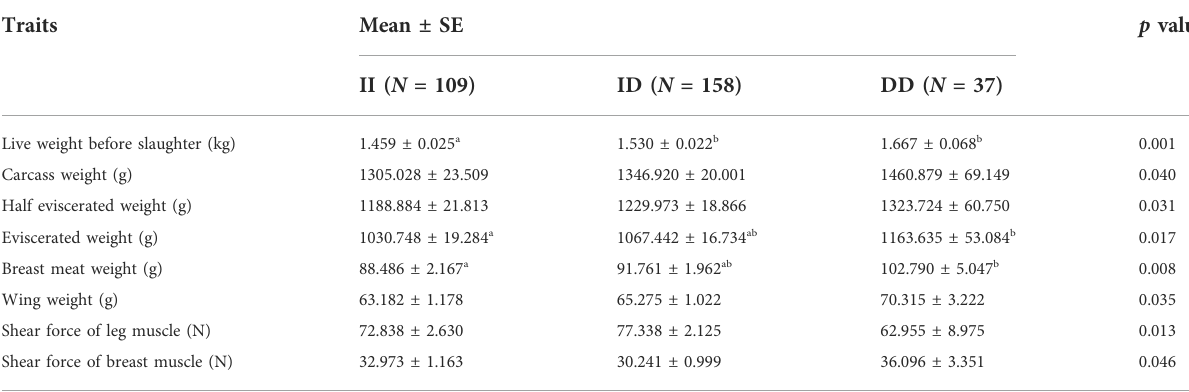
TABLE 1 Traits signi fi cantly associated with chicken RPL3L 42 bp indel.